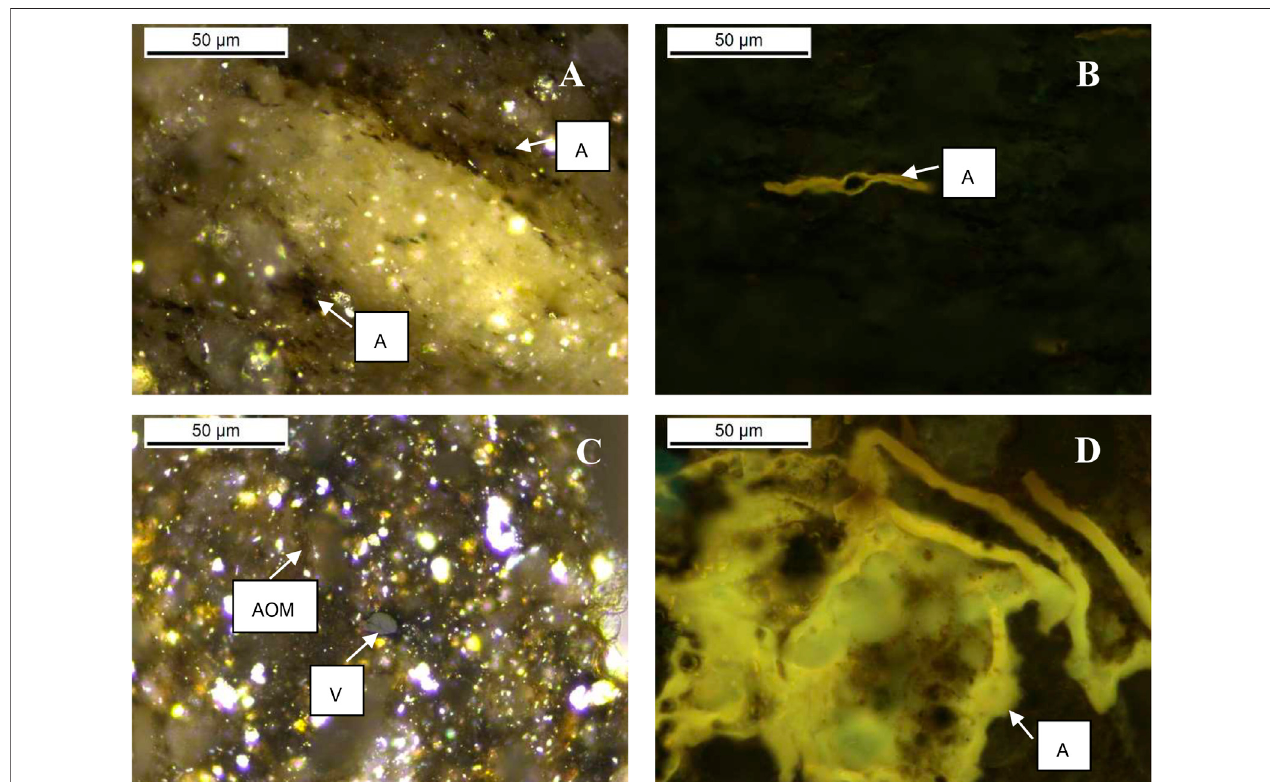
FIGURE 6 | Organic petrography photomicrographs (oil immersion, white incident light, and fl uorescent light) showing typical types and morphology of organic matter in New Albany Shales. Panels (A,B) were taken on samples from NAS 472-RD . Panels (C,D) were taken on samples from NAS IN3 containing mainly alginite. The most representative organic matter in New Albany Shale is alginite. Abbreviations: V – vitrinite, AOM – amorphous organic matter, A – alginite.